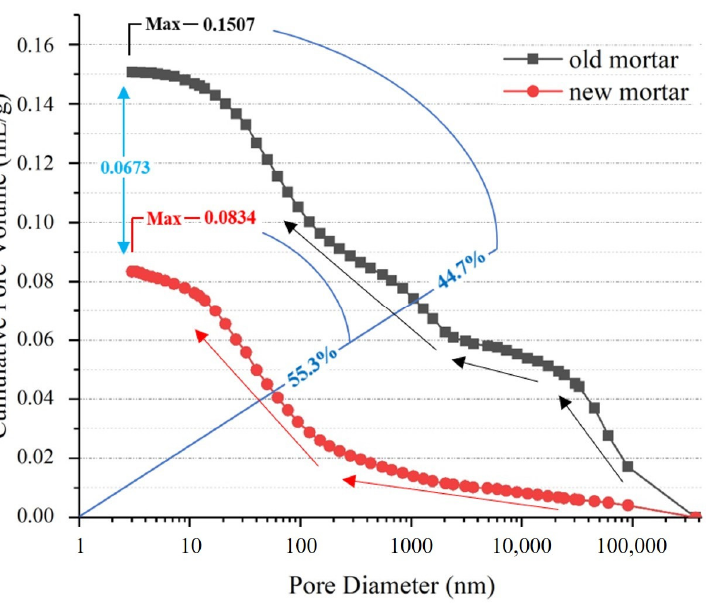
Figure 1. Trend of pore size and accumulated pore volume of OM and NM. Note: the mercury intrusion process is from the positive direction of the X-axis to the origin.